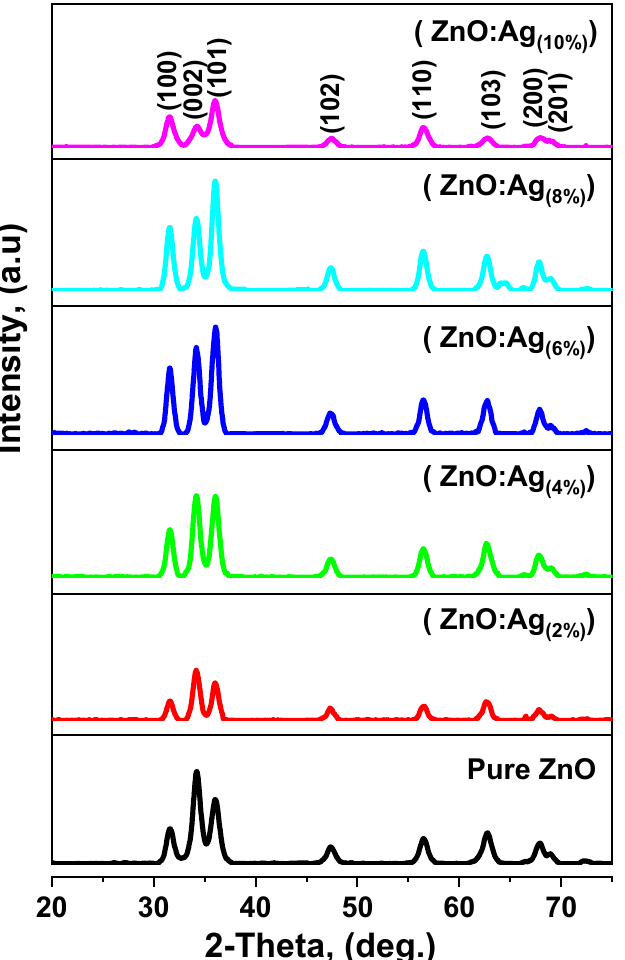
Figure 4. XRD spectra of samples undoped and Ag doped ZnO synthesized by LACBS.